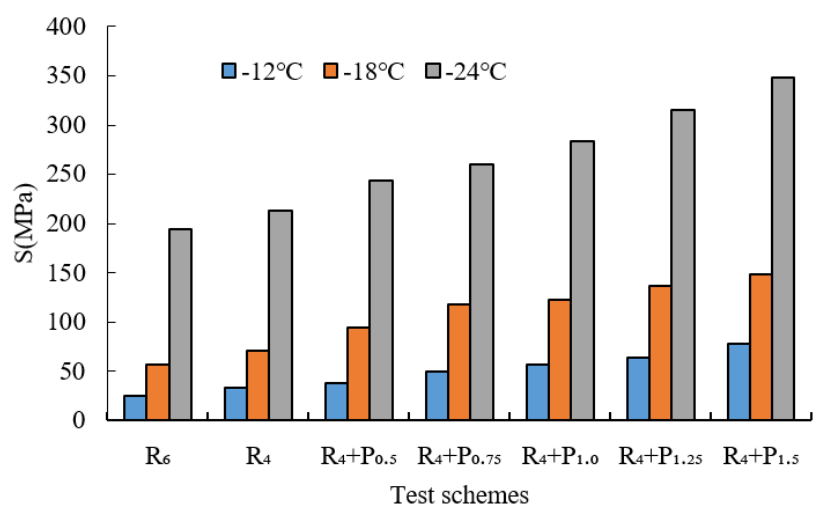
Figure 15. Creep stiffness of PPA – SBR and LH – 90# asphalt.